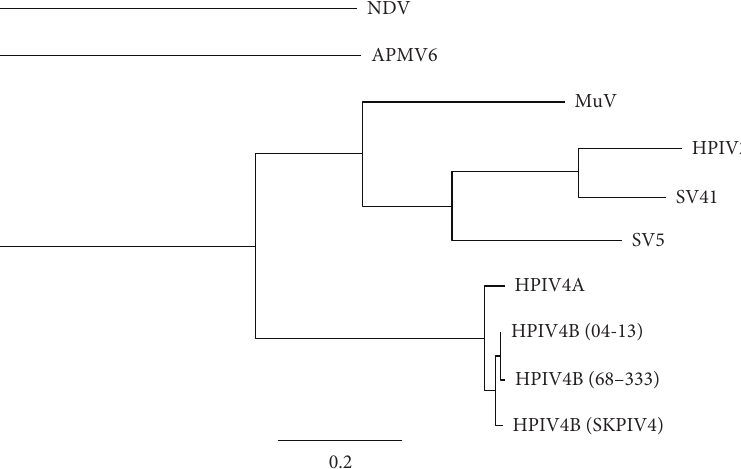
F 1: Phylogram depicting the relationship of hPIV-4B isolate 04-13 to representative members of the genus Rubulavirus . Tree based on the concatenated deduced amino acid sequences of the F, H-N, L, M, NP, and P proteins (4442 amino acid characters including gaps). Members of the genus Avulavirus ( Newcastle disease virus ; NDV and Avian paramyxovirus 6 ; APMV6) were included as outgroups. All nodes were supported by a posterior probability of 100. Branch lengths are based on the number of inferred substitutions, as indicated by the scale. Gene sequences were obtained from the complete genomic sequences for NDV (RefSeq accession no. NC_002617), APMV6 (NC_003043), Mumps virus (MuV; NC_002200), �uman parain�uen�a virus � (HPIV2; NC_003443), Simian virus 41 (SV41; NC_006428), Simian